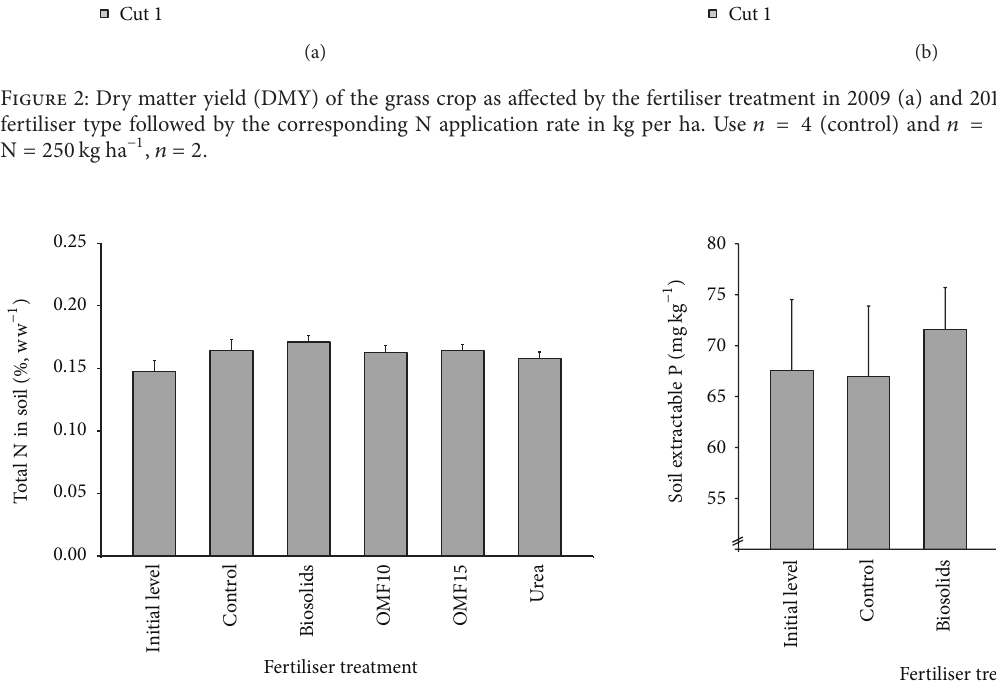
Figure 4: Mean soil extractable P over the range of fertiliser appli- cation rates used in the experiment. The initial level corresponds to the baseline level prior to the start of the experiment. Use 𝑛 = 14 except for initial level and control 𝑛 = 3 ; 𝑃 = 0.92 (control versus treatments), 𝑃 = 0.01 (treatments). The error bars show the LSD value at 5%